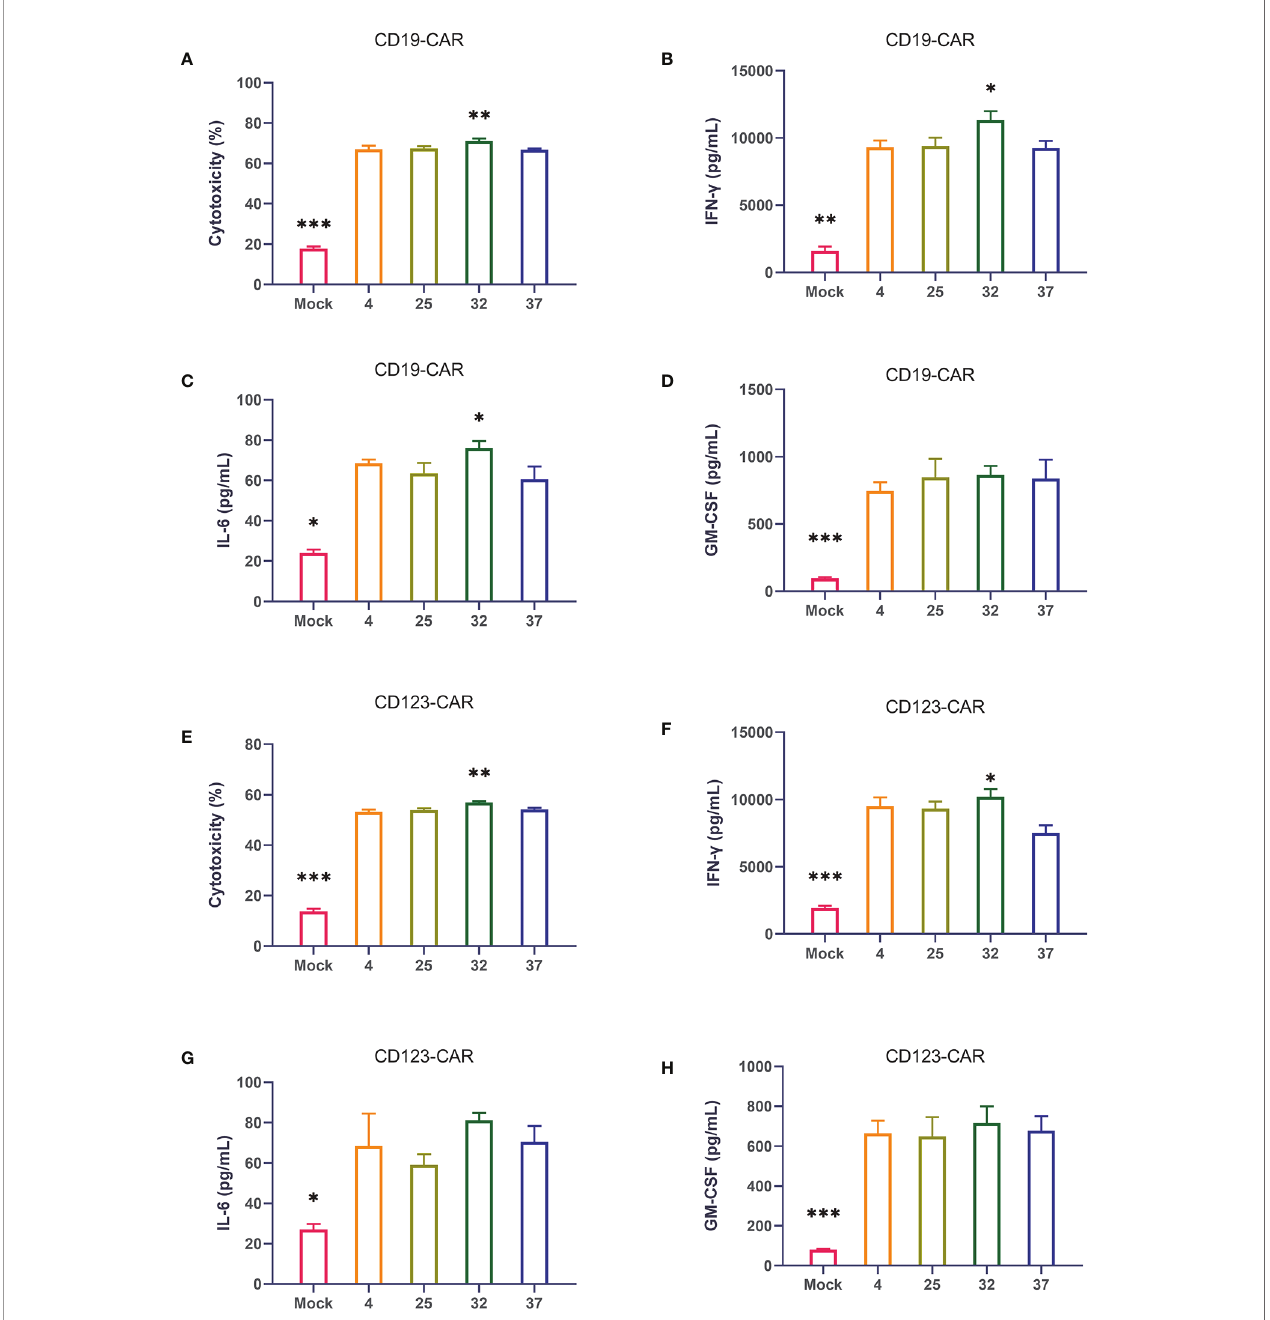
FIGURE 4 | 32-Degree infection generates CAR-T cells with optimal cytotoxicity and cytokine secretion (A – D) Determination of the cytotoxicity of CD19 CAR-T cells generated at different infection temperatures. CD19 CAR-T cells were coincubated with CD19-positive NALM-6 cells for 24 hours, and the concentrations of IFN- g , IL-6 and GM-CSF in the culture supernatant were detected. (E – H) Determination of the cytotoxicity of CD123 CAR-T cells generated at different infection temperatures. CD19 CAR-T cells were coincubated with CD123-positive MOLM-13 cells for 24 hours, and the concentrations of IFN- g , IL-6 and GM-CSF in the culture supernatant were detected. Three independent experiments were conducted. Mean ± SD. *p < 0.05, **p< 0.01, ***p <